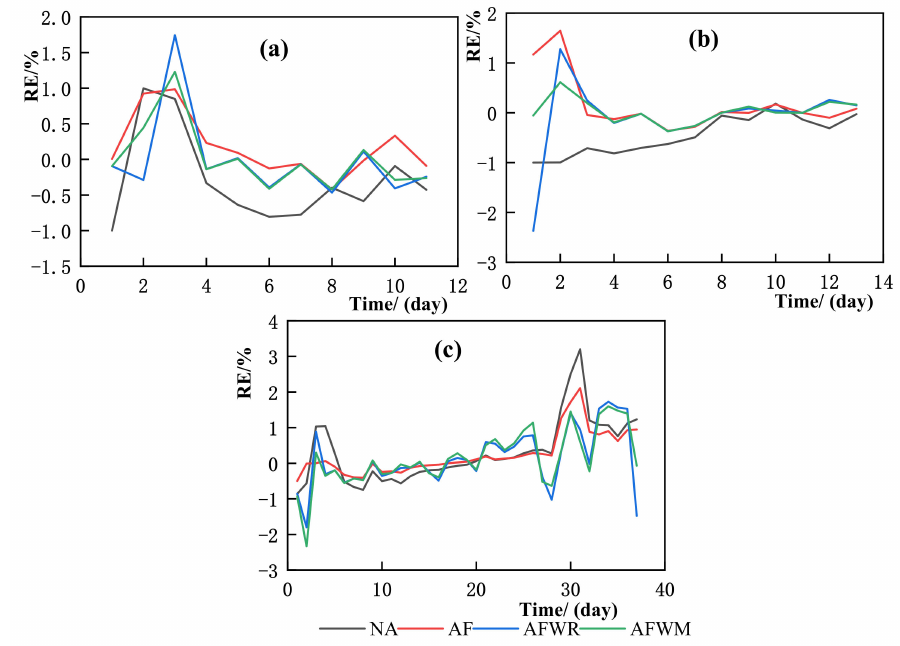
Figure 6. The RE values under the four assimilation settings for small floods for the three stations: ( a ) Dage; ( b ) Gubeikou; ( c )